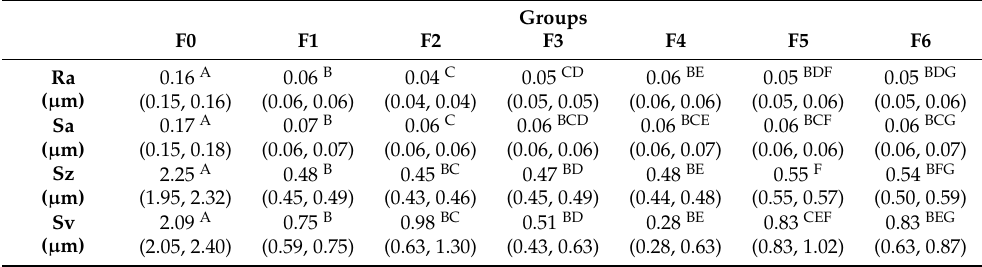
Table 1. Surface roughness parameters of the experimental groups (F0–F6).